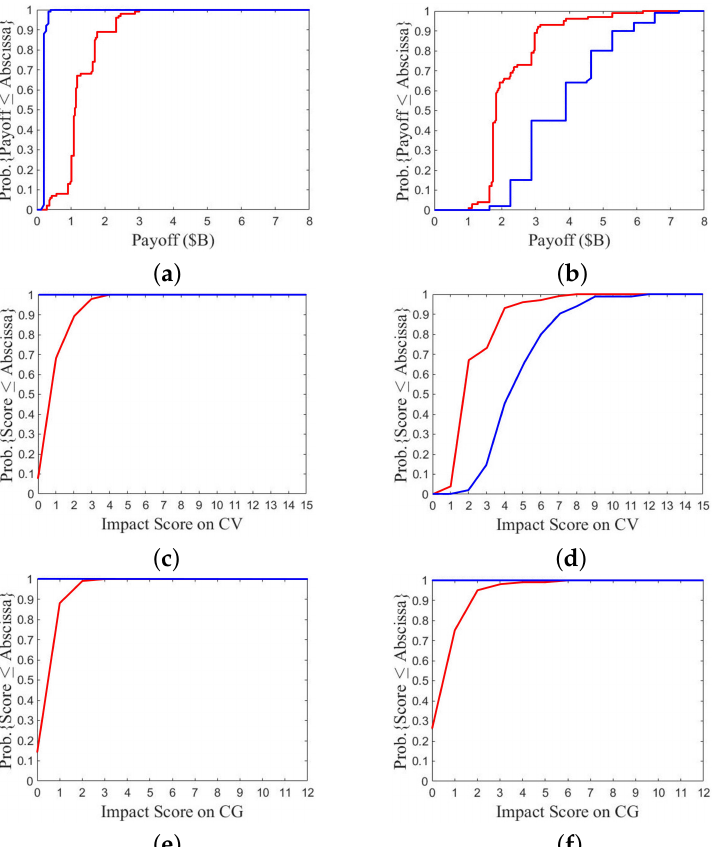
Figure 17. Comparison between A1/B3 and A2/B3 over 100 games with one P 2 SO run. CDF of payoff, ( a ) A1/B3, ( b ) A2/B3. CDF of impact score on CV, ( c ) A1/B3, ( d ) A2/B3. CDF of impact score on CG, ( e ) A1/B3, ( f ) A2/B3. ———: fleet A, ———: fleet B.